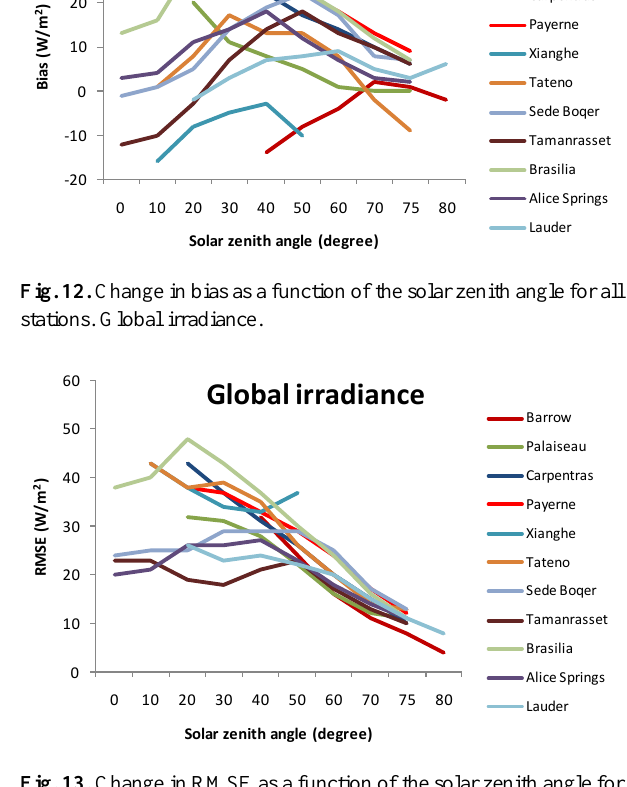
Fig. 13. Change in RMSE as a function of the solar zenith angle for all stations. Global irradiance.